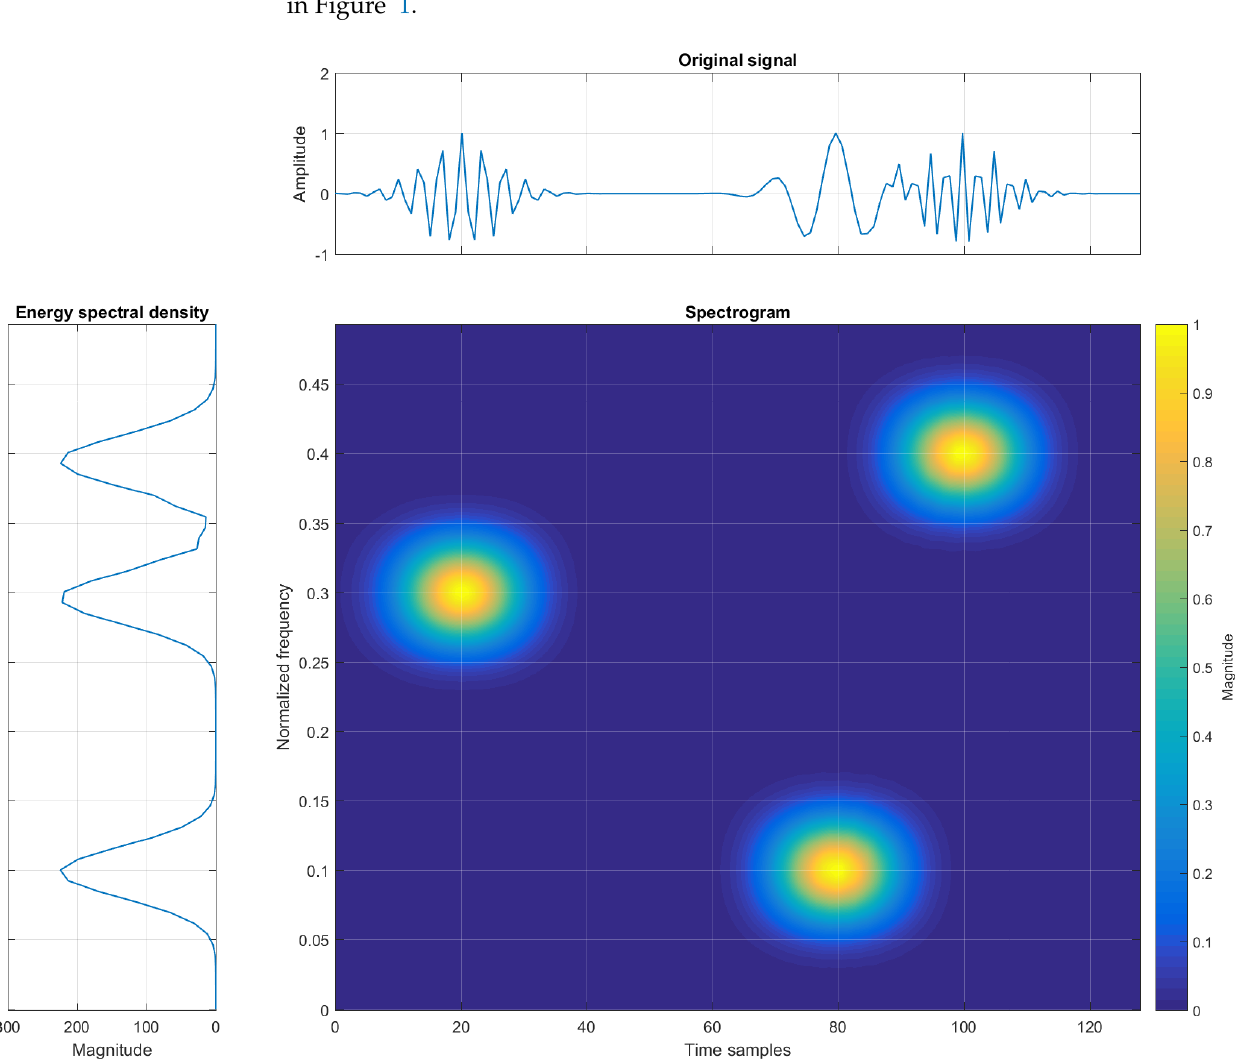
Figure 1. Example of three elementary Gaussian atoms in time, frequency, and TF domains